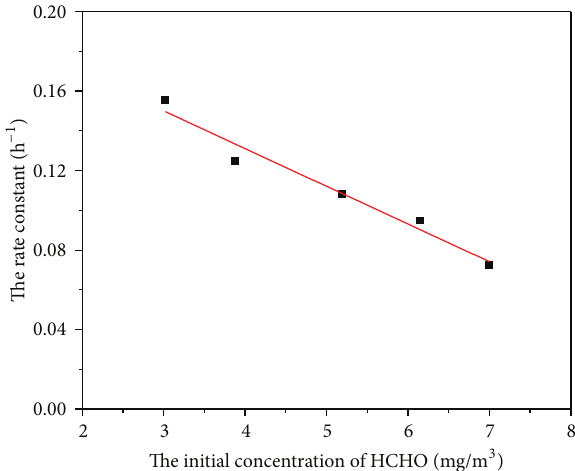
Figure 9: The relationship of reaction rate constant and initial concentration of HCHO.